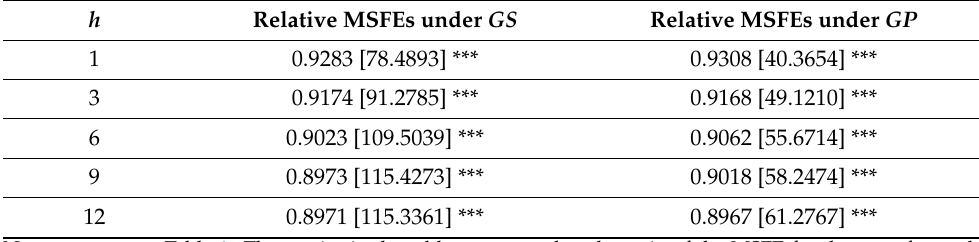
Table 2. Out-of-sample Forecasting Results. h Relative MSFEs under